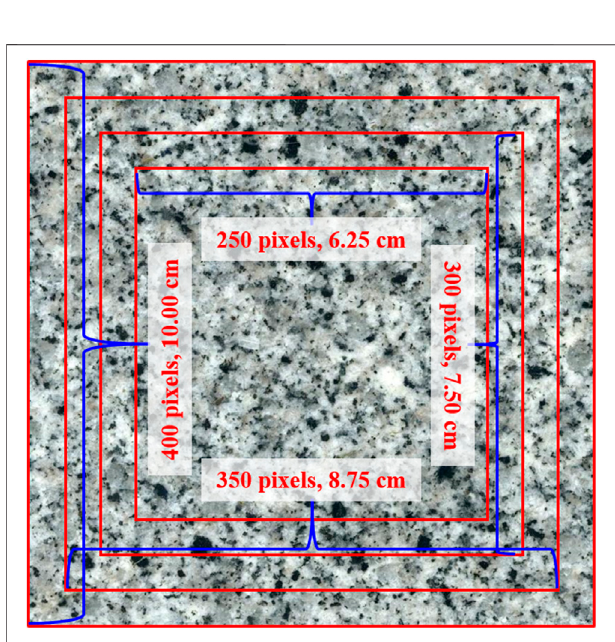
FIGURE 8 | Different sizes of the control group of natural